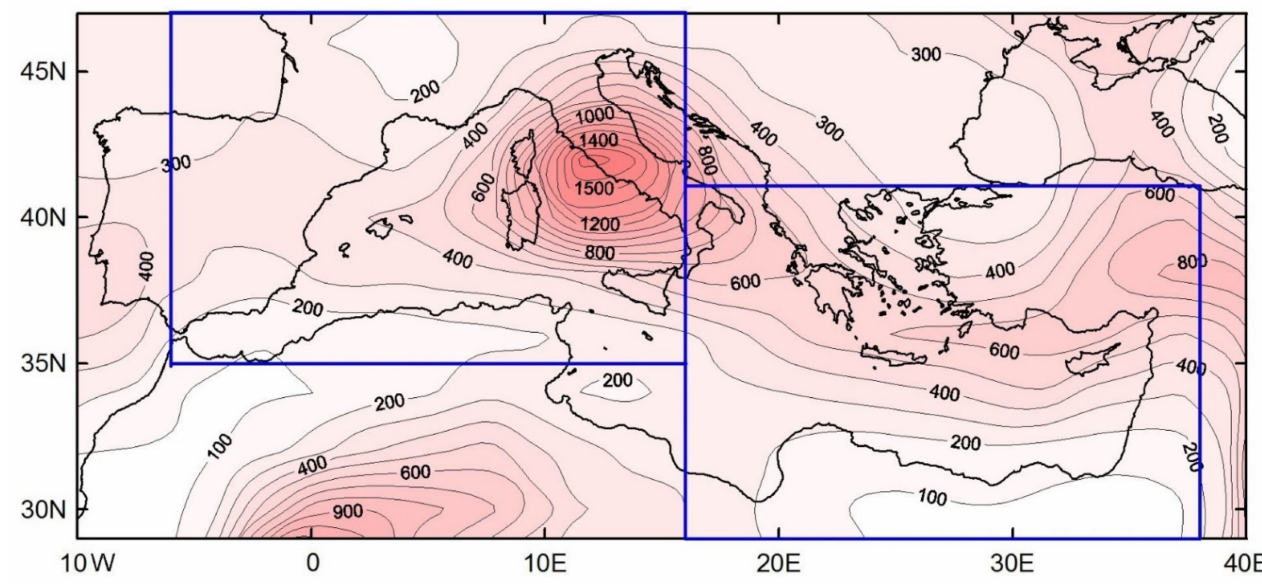
Figure 1. The total number of the centers of all identified local minima for the 1951–2017 period on a 6-h basis (red shading) and the boundaries of the Western and Eastern Mediterranean (blue